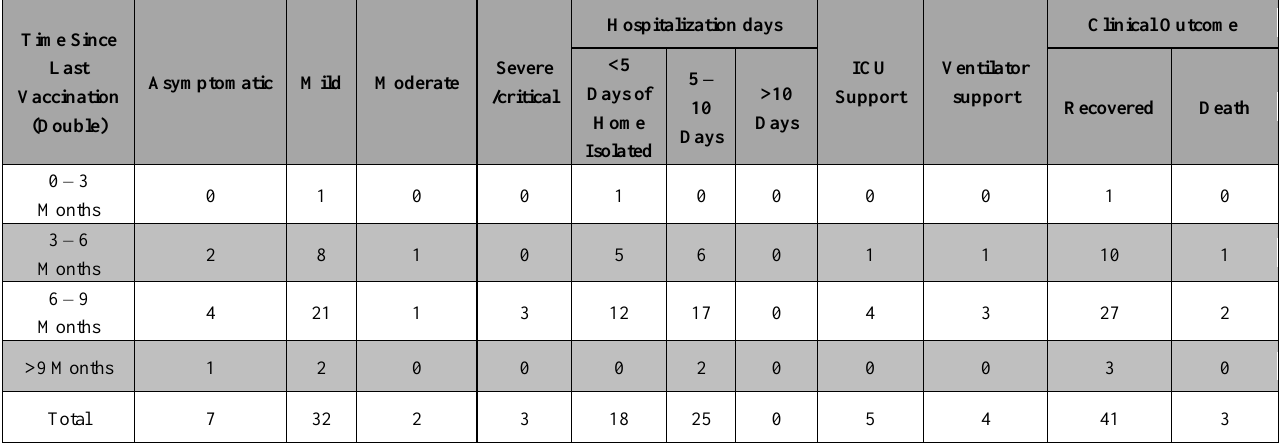
Table 7. Clinical severity with respect to time since Double vaccination.